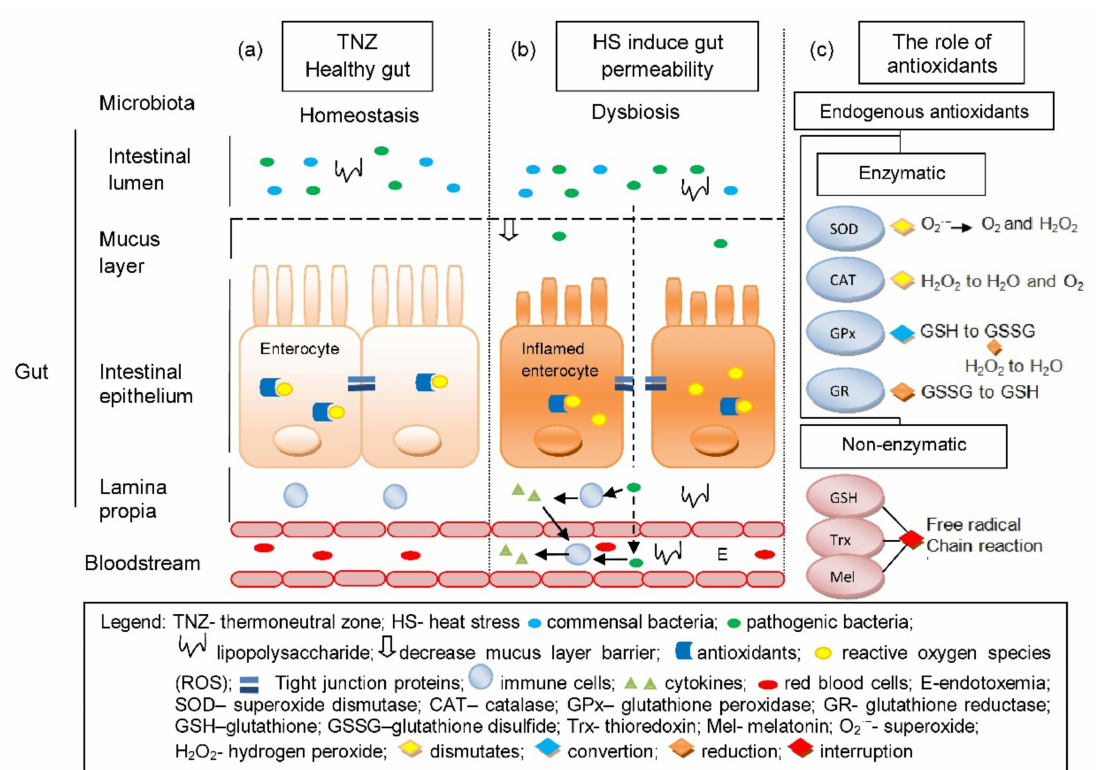
Figure 1. The condition of the gut under thermoneutral zone ( a ) is normal and is considered a healthy gut, as there is a homeostasis in microbiota, antioxidant to ROS balance and a fully functional gut epithelium that prevents the entry of bacteria and toxins. ( b ) HS induces gut permeability, which causes OS due to the imbalance between the endogenous antioxidants and ROS. It also allows translocation of pathogenic bacteria and toxins into the blood circulation via paracellular transport due to the disruptions of TJs and can lead to endotoxemia. ( c ) The role of endogenous antioxidants in cellular redox balance through elimination of